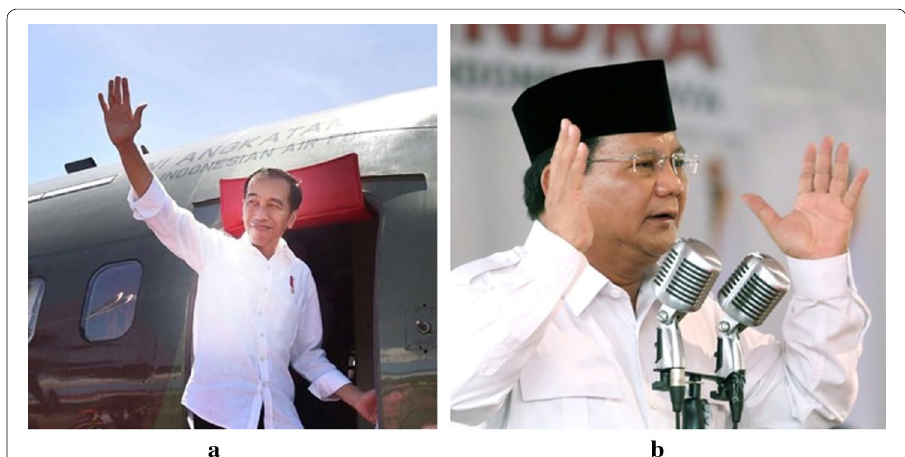
Fig. 1 Joko Widodo has the style that is calm and simple a and Prabowo Subianto has a style that always shows patriotism and a former general b (source: